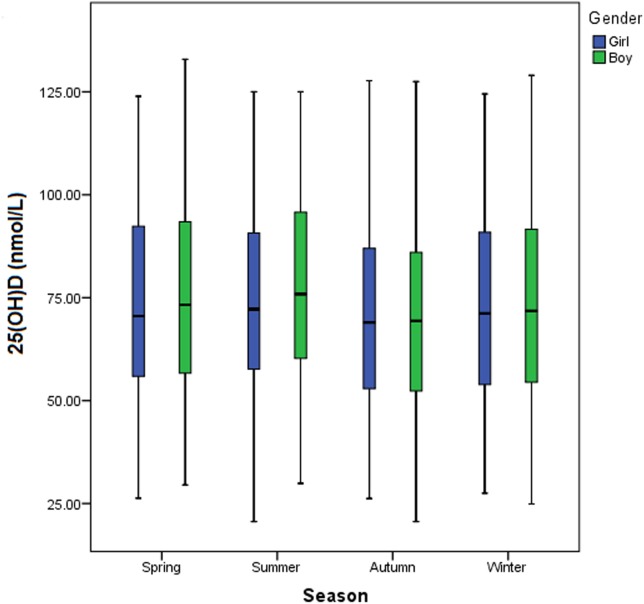
Comparison of the serum 25(OH)D concentration among young children in different seasons.The serum 25(OH)D level was highest in summer and lowest in autumn.